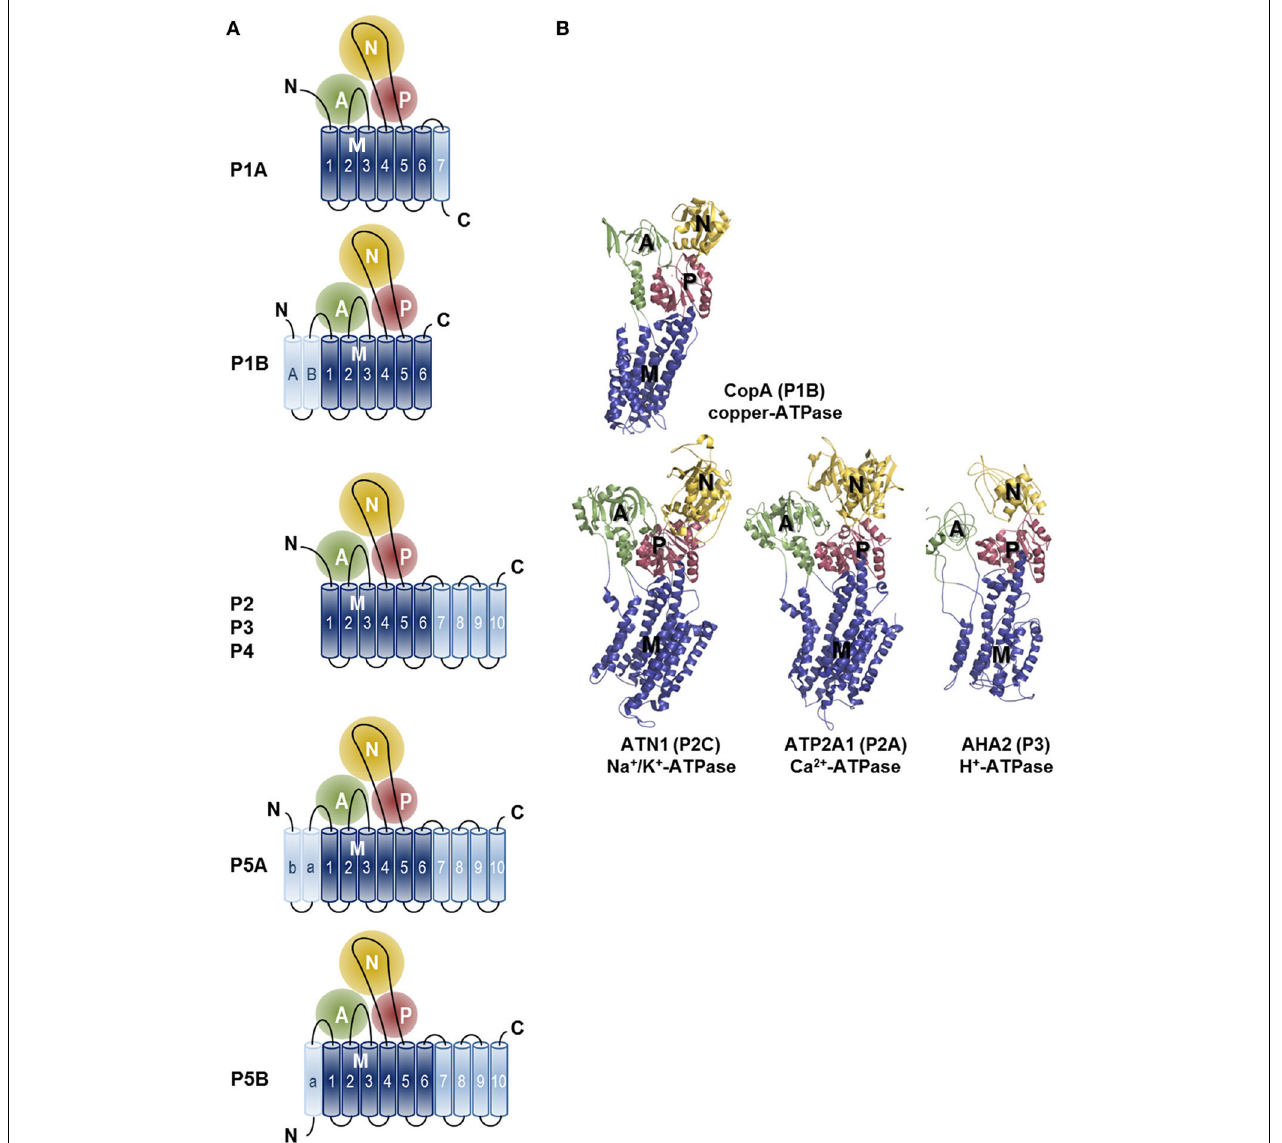
FIGURE 3 | Topology and architecture of the catalytic subunits of P-type ATPases. (A) Planar topology models of the five classes of P-type ATPases (P1-P5). Nucleotide-binding domains (N, yellow), actuator domains (A, green) and phosphorylation domains (P, red) are indicated. The 6 TM helices (Polymeropoulos et al., 1997; Spillantini et al., 1997; Jankovic, 2008; Lees et al., 2009; Auluck et al., 2010; Tolleson and Fang, 2013) form the core segment of the membrane (M) domain of all P-type ATPases, which is depicted in dark blue, whereas additional N- and C-terminal helices are shown in light blue. Of note, there is one exception for the P2 ATPases, a splice